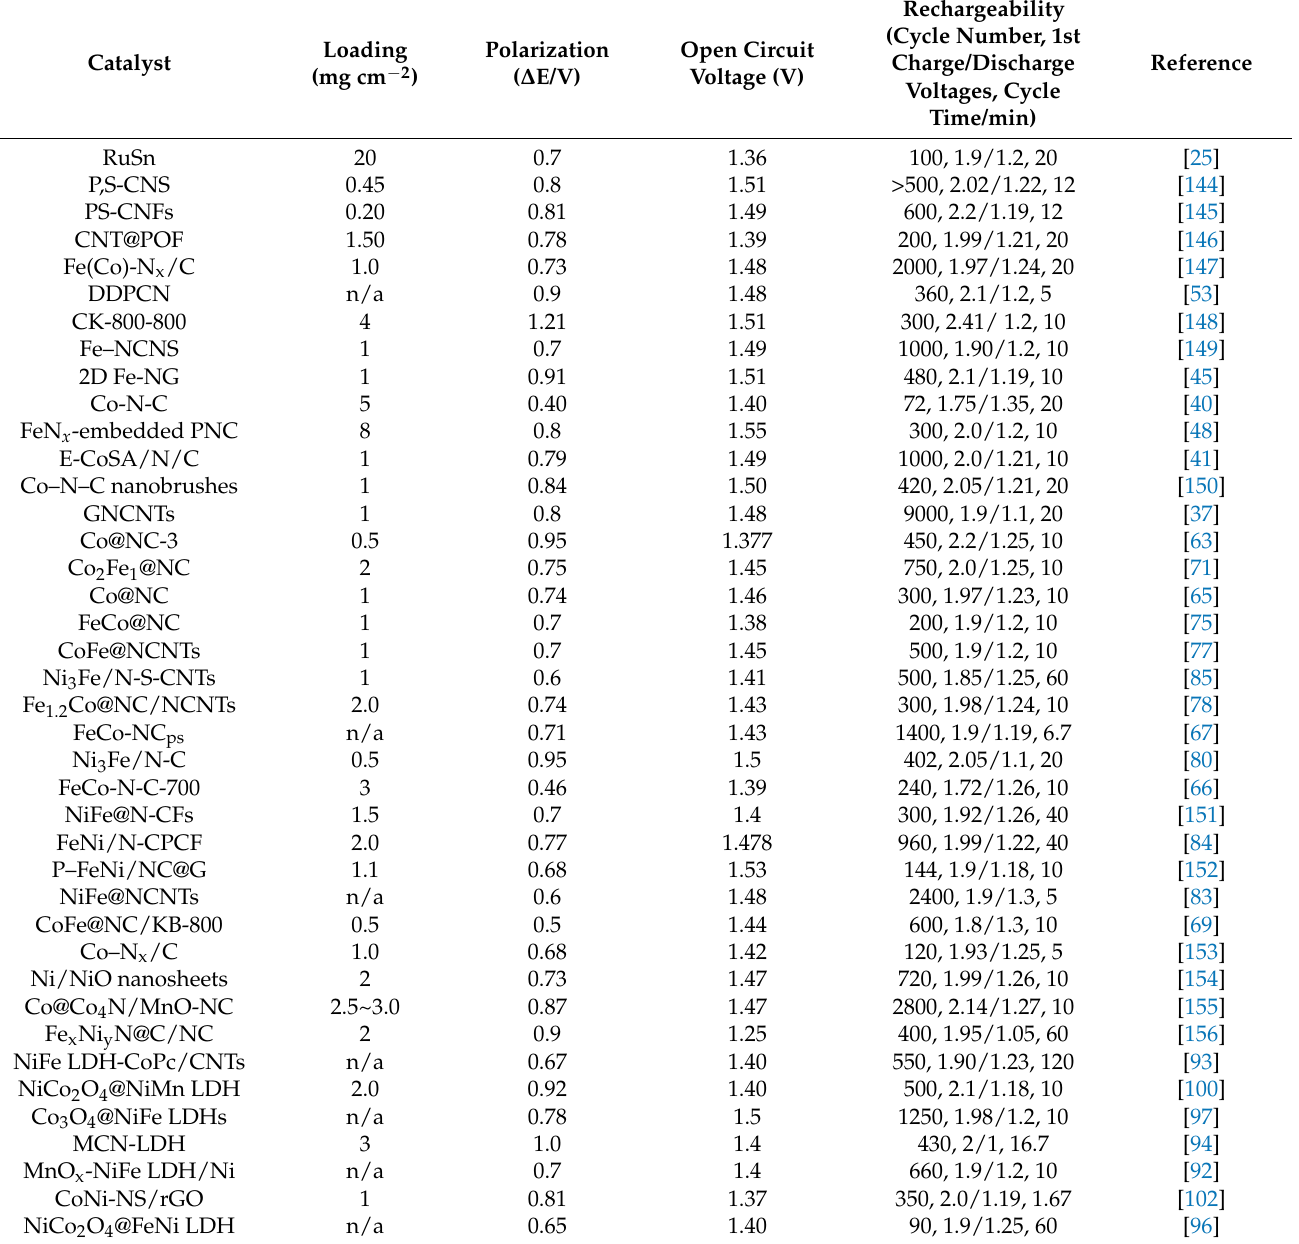
Table 4. Performances of some typical